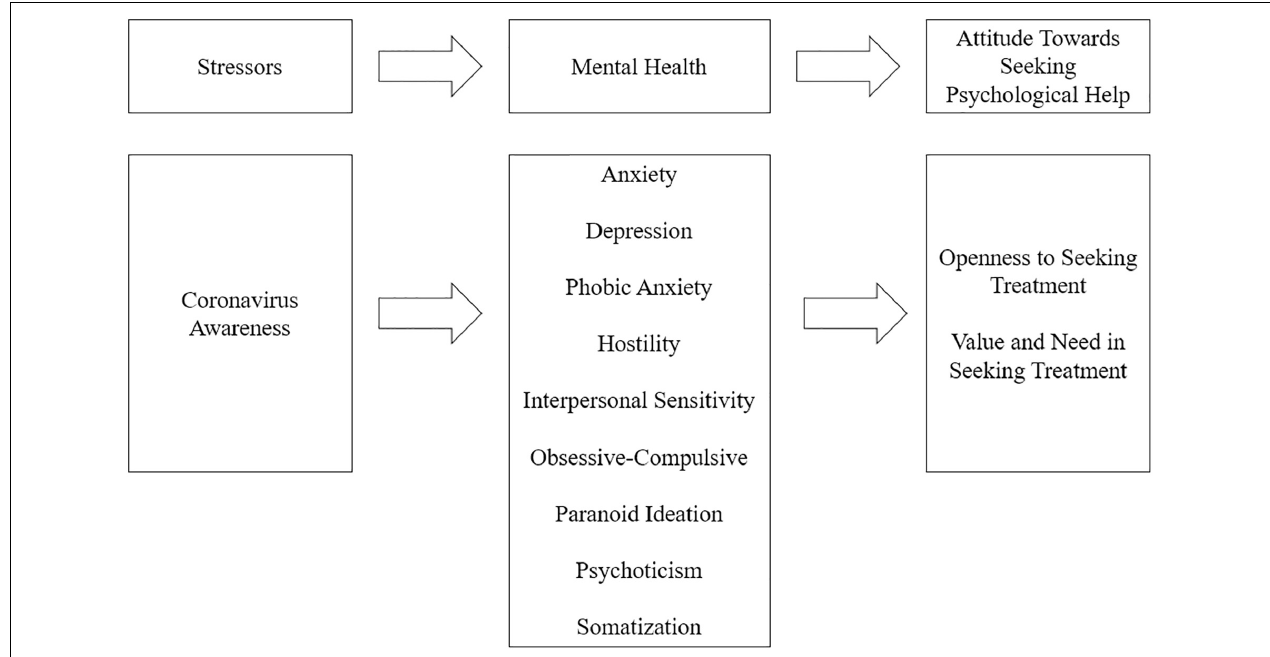
FIGURE 1 | A proposed mediation model with Coronavirus Awareness as predictor, mental health symptoms as mediators and the attitude toward seeking psychological help as outcome. TABLE 1 | Factor loadings for the